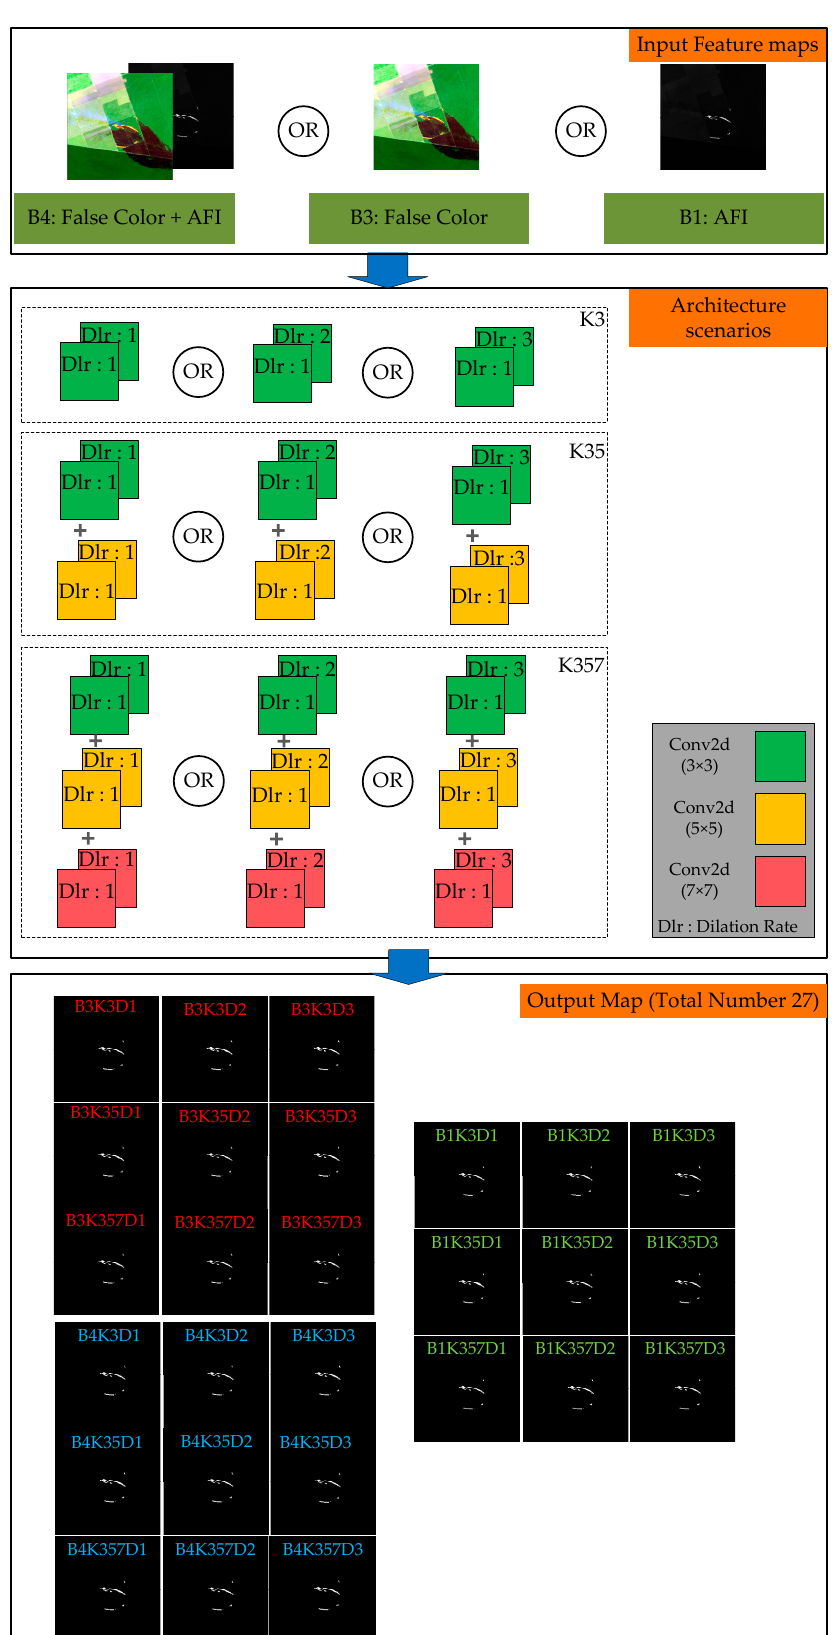
Figure 2. Different scenarios based on the number of inputs, multi-size kernels, and DCLs with different dilation rates in MultiScale-Net for AFD.